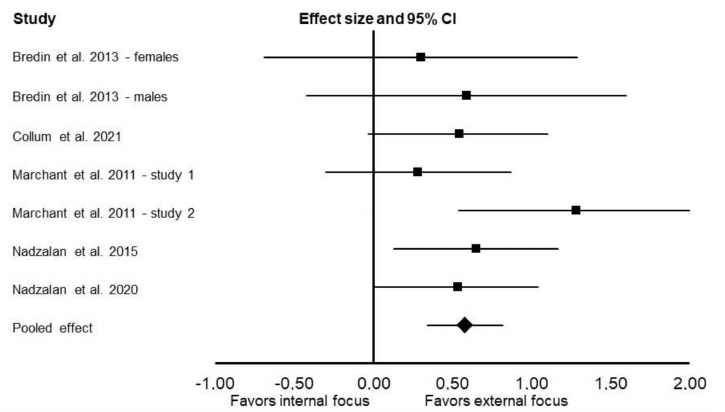
Figure 2. Results of the random-effects meta-analysis comparing the effects of external focus vs. in- ternal focus on muscular endurance. Data are reported as effect sizes (Cohen’s d ) and 95% confidence interval (CI). The diamond at the bottom presents the overall effect. The plotted squares denote effect sizes, and the whiskers denote their 95% CIs.